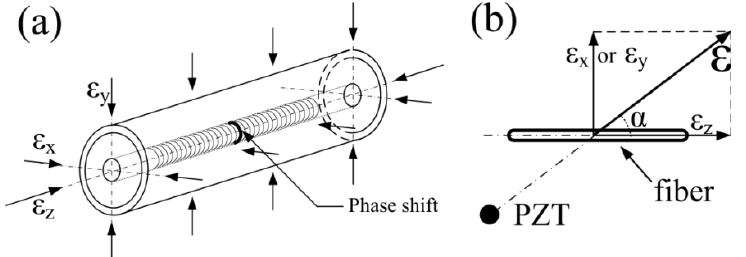
Figure 2. Theoretical principle. ( a ) PS-FBG subjected to strains in three orthogonal axes. ( b ) Directional strain impacts on an optical